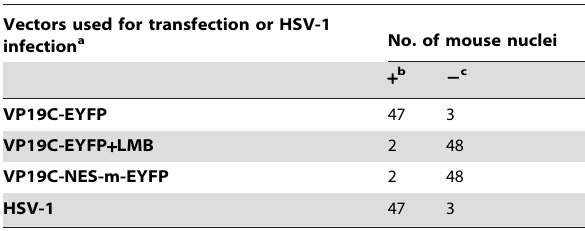
Table 1. Heterokaryon assay cell